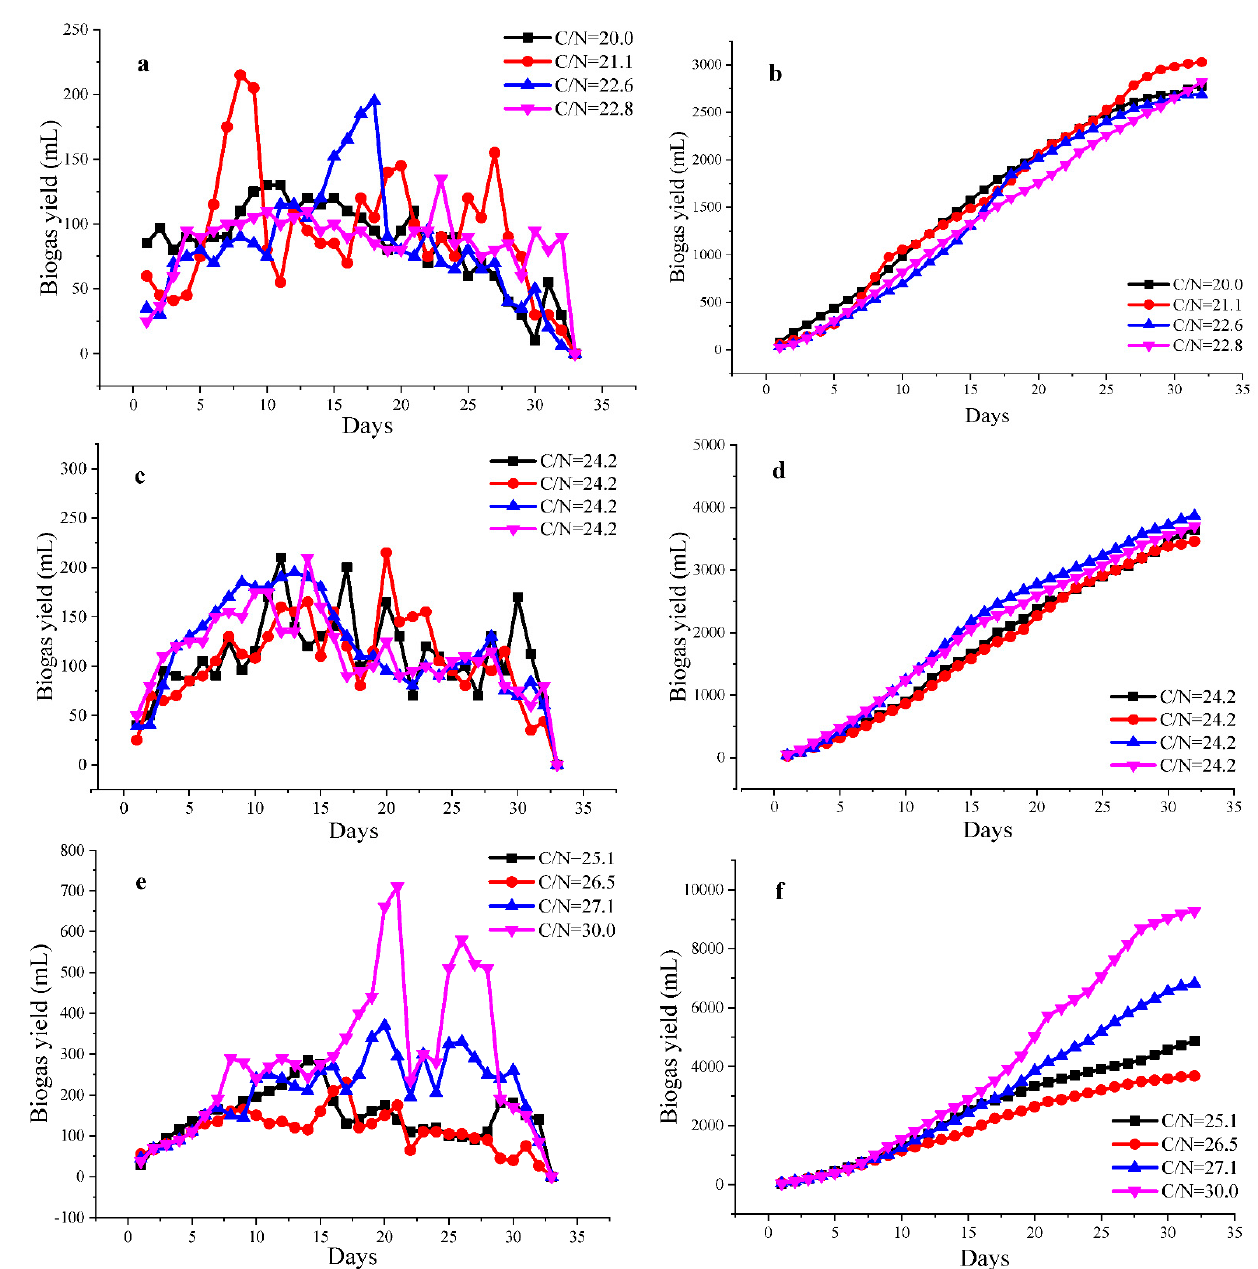
Figure 6. ( a , c , e ): daily biogas yield, ( b , d , f ): cumulative biogas yield. C and d are the replicates of medium C/N ratio 24.2.